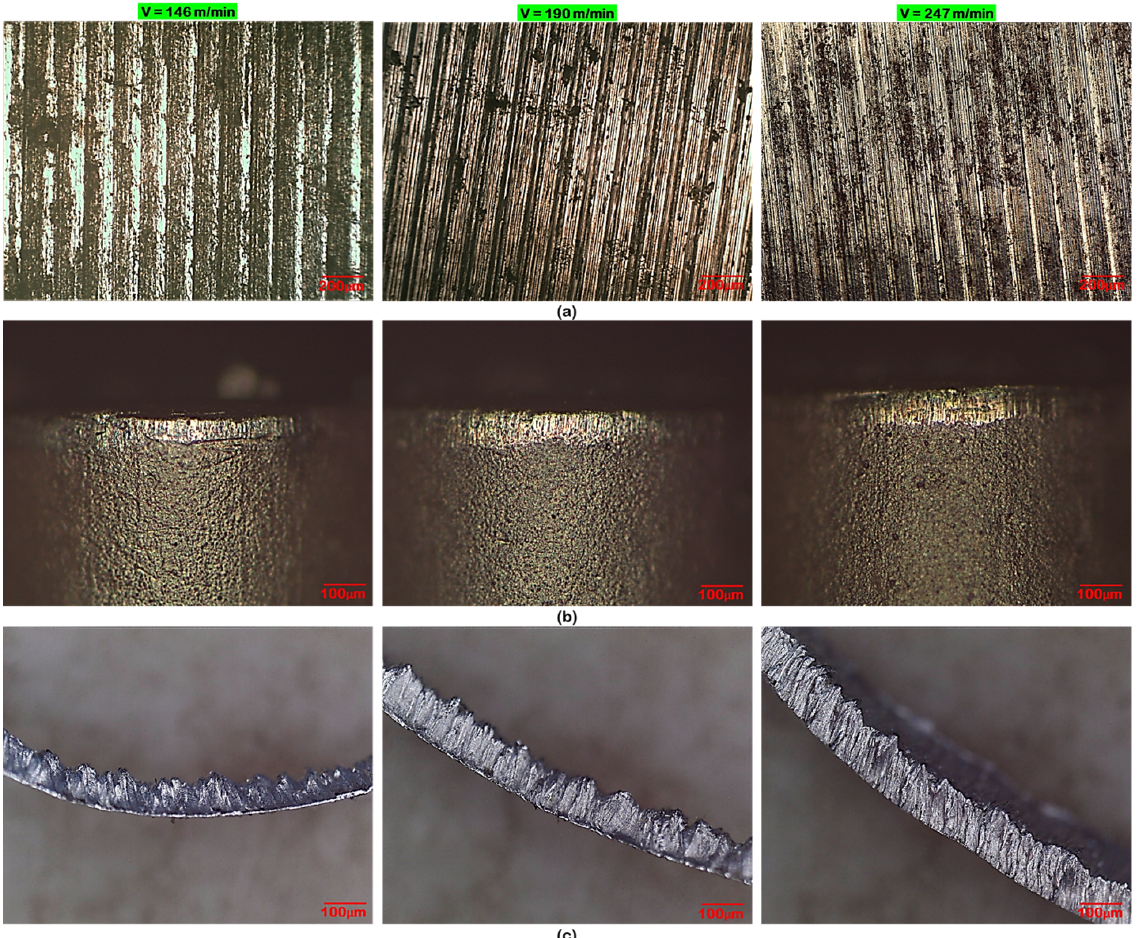
Figure 13. Machining performance assessment under different speeds concerning: ( a ) machined surface morphology, ( b ) tool flank wear, and ( c ) chip thickness.